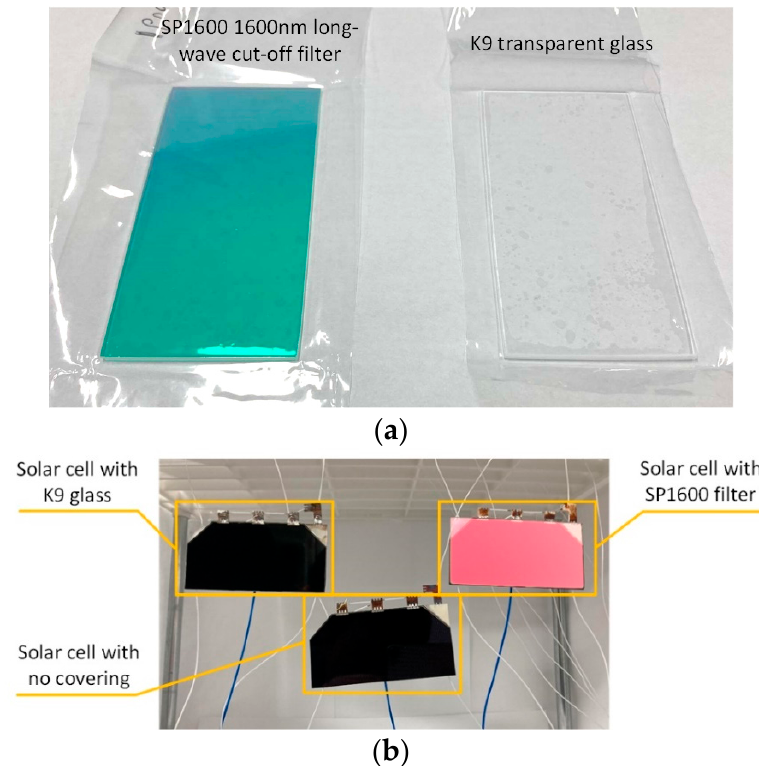
Figure 7. Materials used in the test. ( a ) Filter and transparent glass. ( b ) Solar cell with filter, with glass and with no covering.